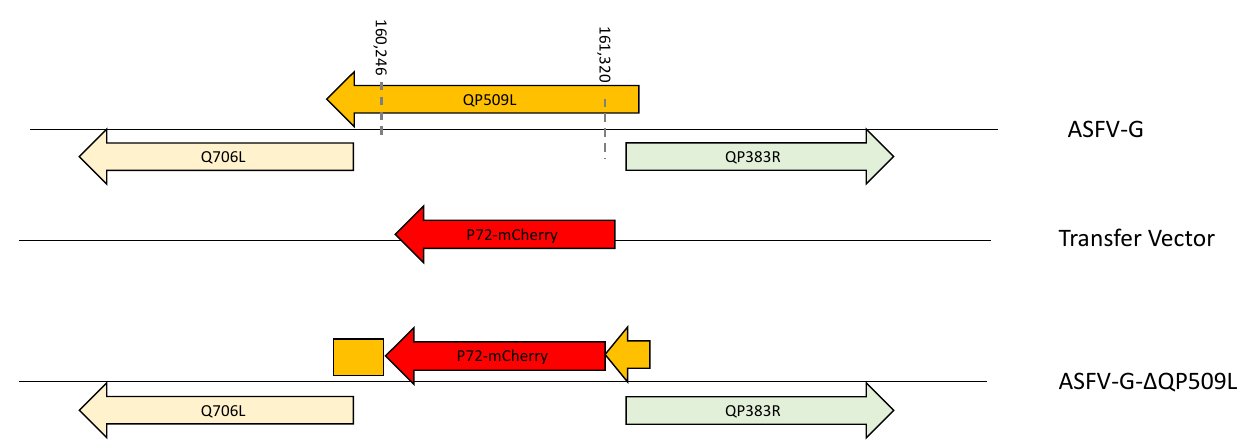
Figure 4. Development of ASFV ‐ G ‐∆ QP509L. The recombinant vector composed of the p72 promoter and an mCherry cassette, as well as the gene positions, are indicated. The homologous arms were designed to have flanking ends on both sides of the deletion/insertion cassette. The nucleotide positions of the deleted area are shown by the dashed lines. The resulting ASFV ‐ G ‐∆ QP509L virus is shown on the bottom, with the orange arrow representing the N ‐ terminal portion of QP509L that remains, and the orange block representing the C ‐ terminal portion of the QP509L that remains without a promotor.